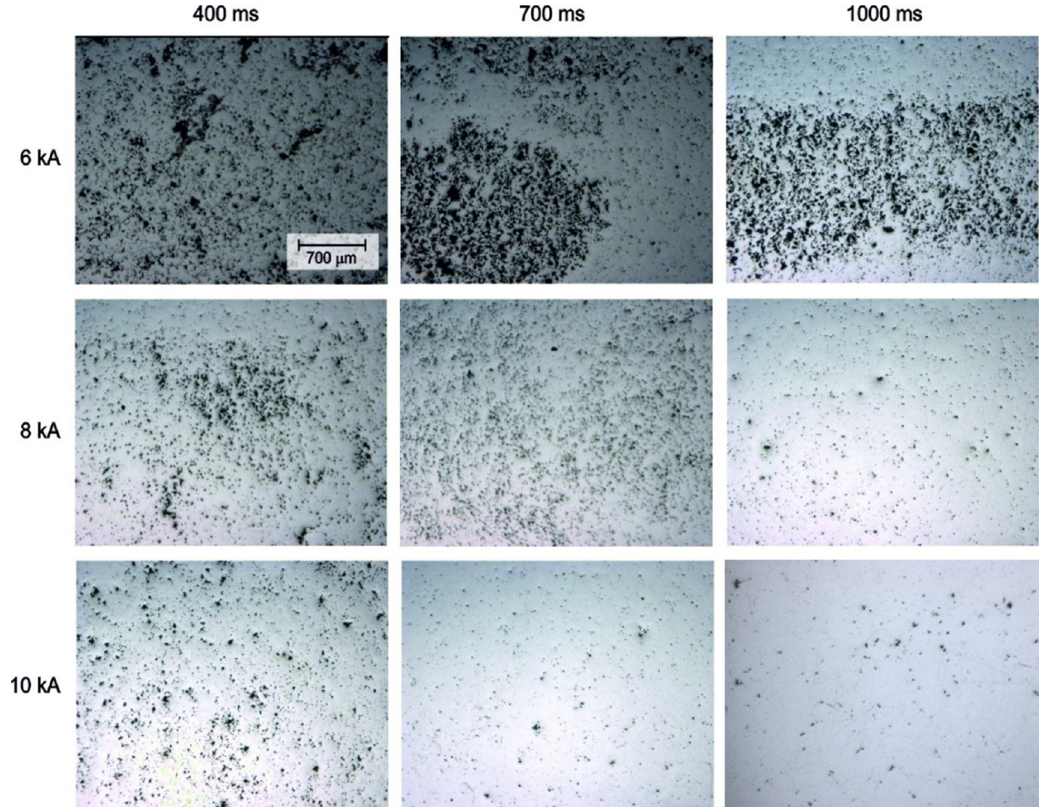
Figure 12. Micrographs showing the porosity distribution at the center of diametrical sections of MF ‐ ERS compacts consolidated under different conditions.